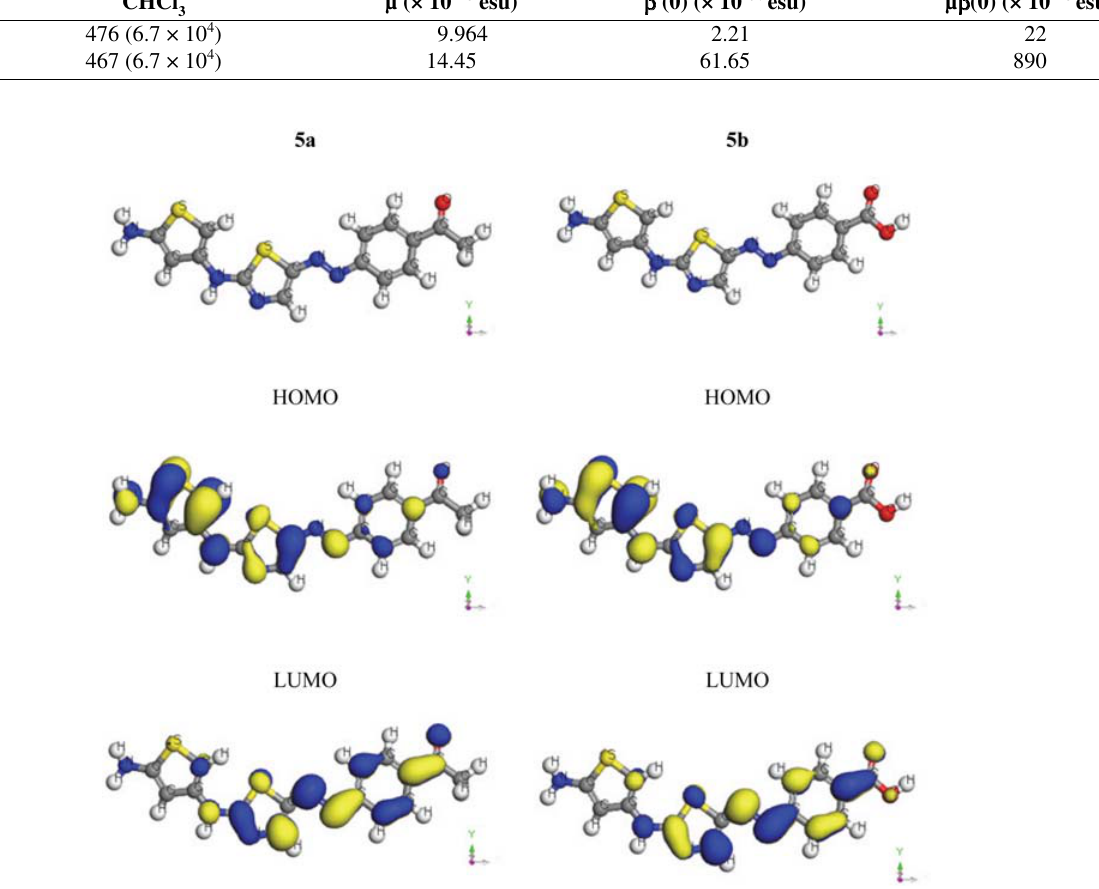
Figure 3 . Molecular orbital’s of the HOMO and LUMO of synthesized organic dyes 5a and 5b calculated with DMol 3